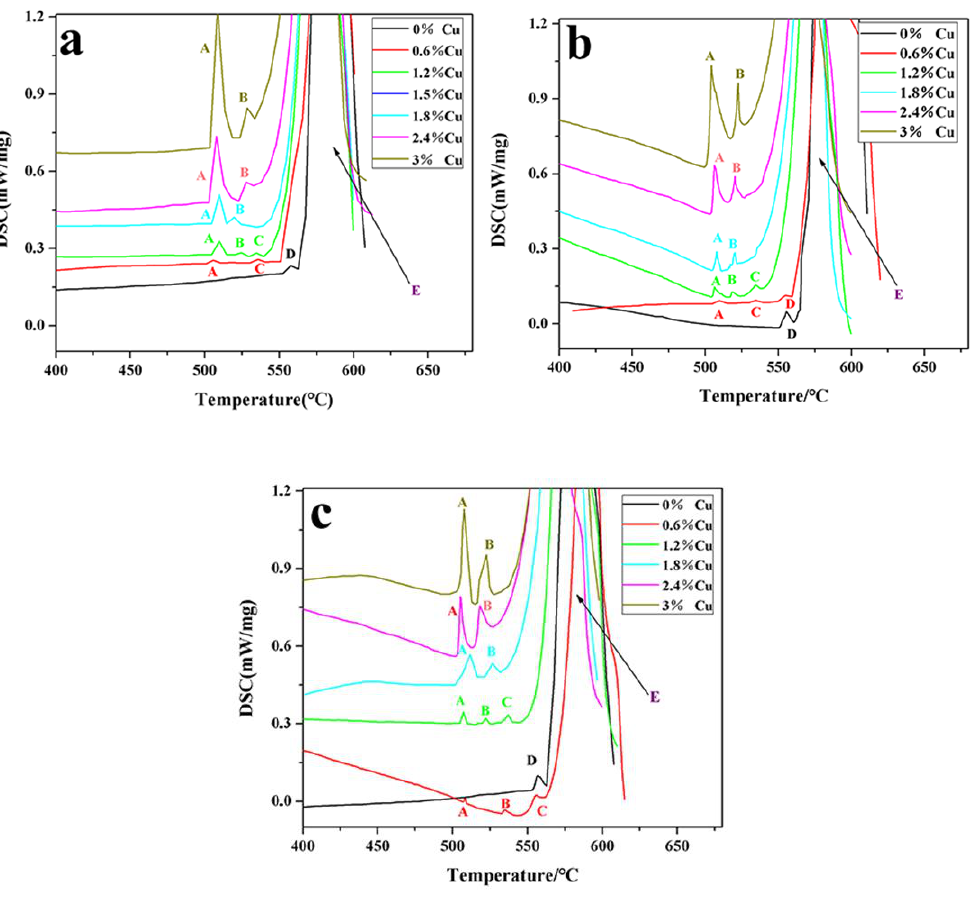
Figure 1. DSC scan of alloys M1 ( a ), M2 ( b ), and M3 ( c ). Table 4. Reaction of endothermic peaks deduced by Mondolfo Table 5. The influence of the evolution of Cu and Mg composition (wt%) on t he area of each endothermic peak (J/g).